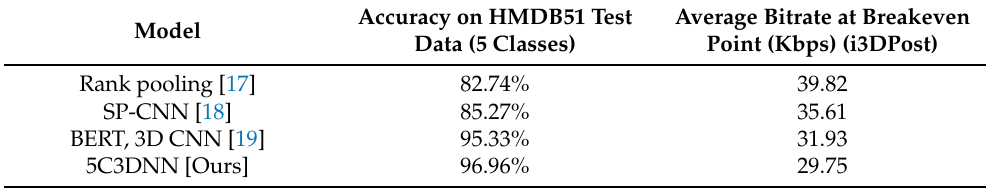
Table 2. Comparison between